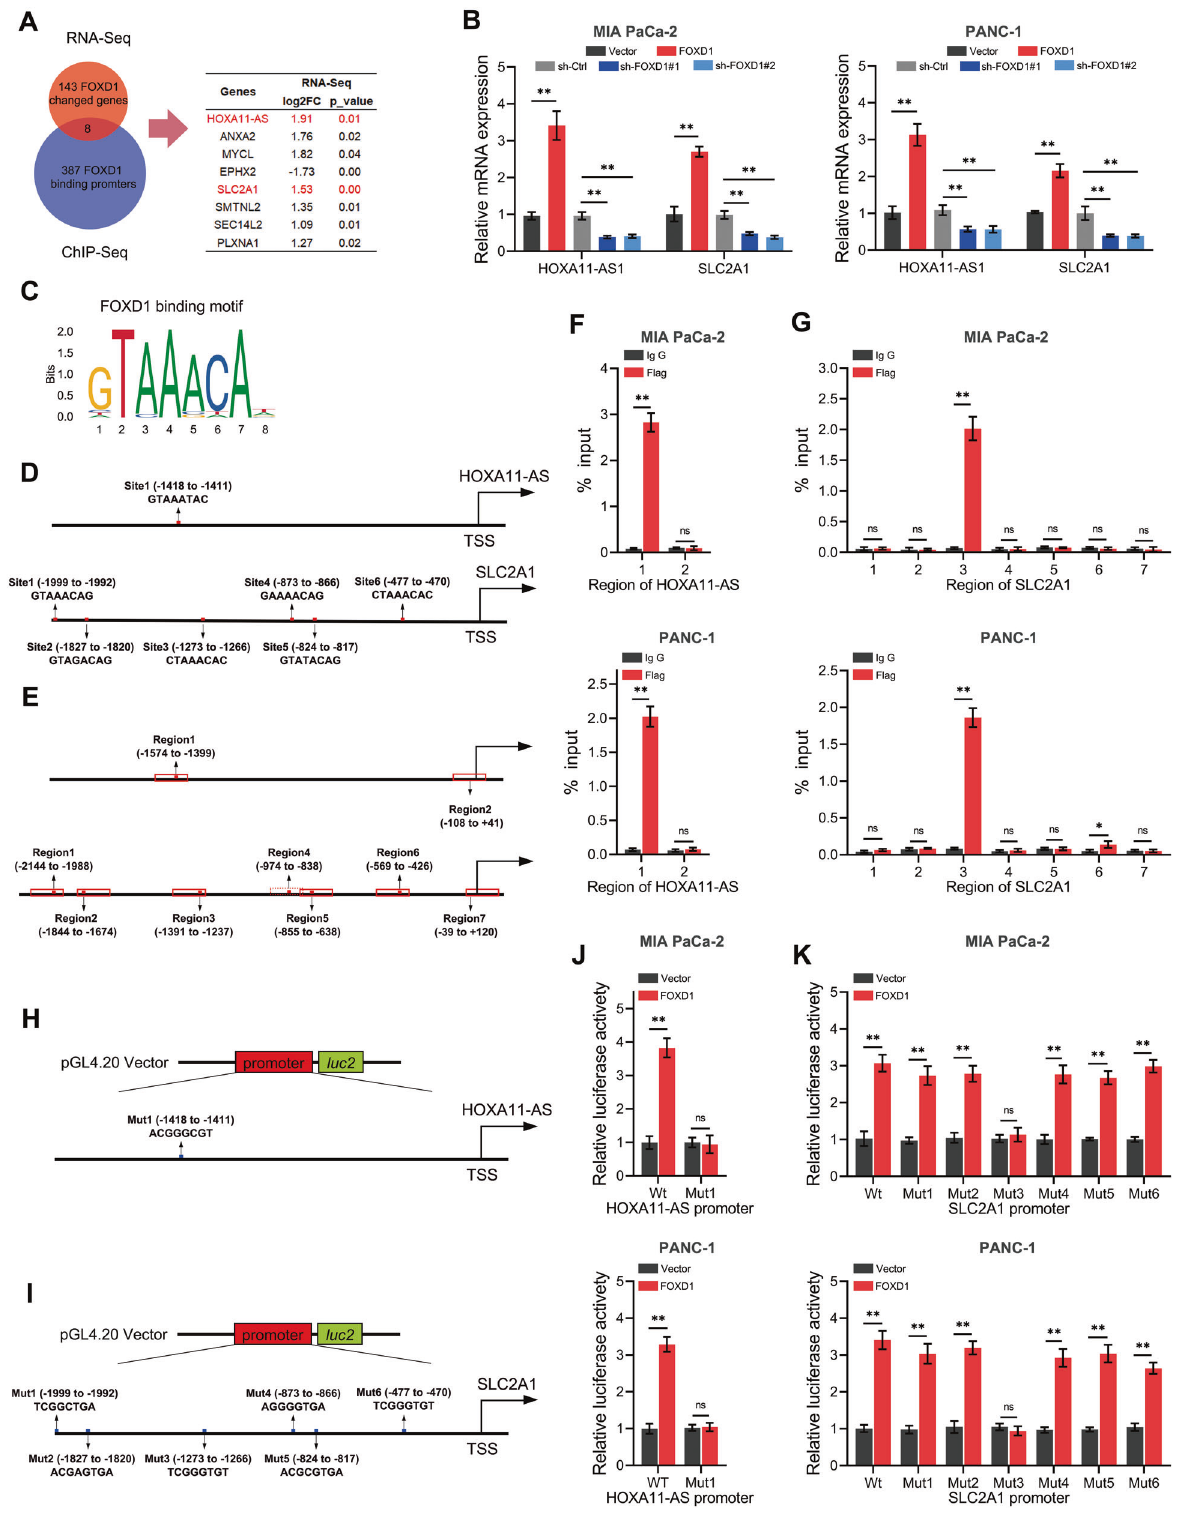
Fig. 4 FOXD1 activates the transcription of SLC2A1 and HOXA11-AS. A The intersection between RNA-Seq and ChIP-Seq in FOXD1 overexpression PANC-1 cell and control cells, represented as a Venn diagram. B Relative HOXA11-AS and SLC2A1 expression of MIA PaCa-2 and PANC-1 cells with FOXD1 overexpression and knockdown were detected by RT-qPCR. C FOXD1 binding motif predicted by JASPAR. D Schematic diagram of potential FOXD1 binding sites in the promoter region of HOXA11-AS and SLC2A1. E Schematic diagram of primers designed for regions of HOXA11-AS and SLC2A1 promoter. F , G ChIP-PCR analysis of enrichment of FOXD1 on HOXA11-AS or SLC2A1 promoter. IgG was used as a negative control. H , I Schematic diagram of dual-luciferase reporter vector construction for HOXA11-AS or SLC2A1 promoter. J , K The luciferase activity of the wild-type and mutant HOXA11-As or SLC2A1 promoters with indicated cells. * p < 0.05; ** p < 0.01. Cell Death and Disease (2022)